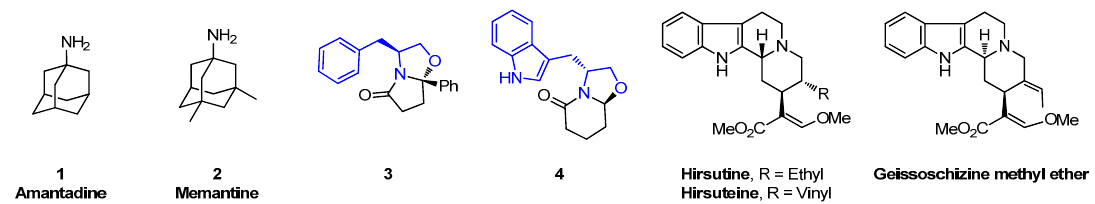
Figure 1. Chemical structure of N -methyl- D -aspartate receptor antagonists and natural products hirsutine, hirsuteine, and geissoschizine methyl ether.